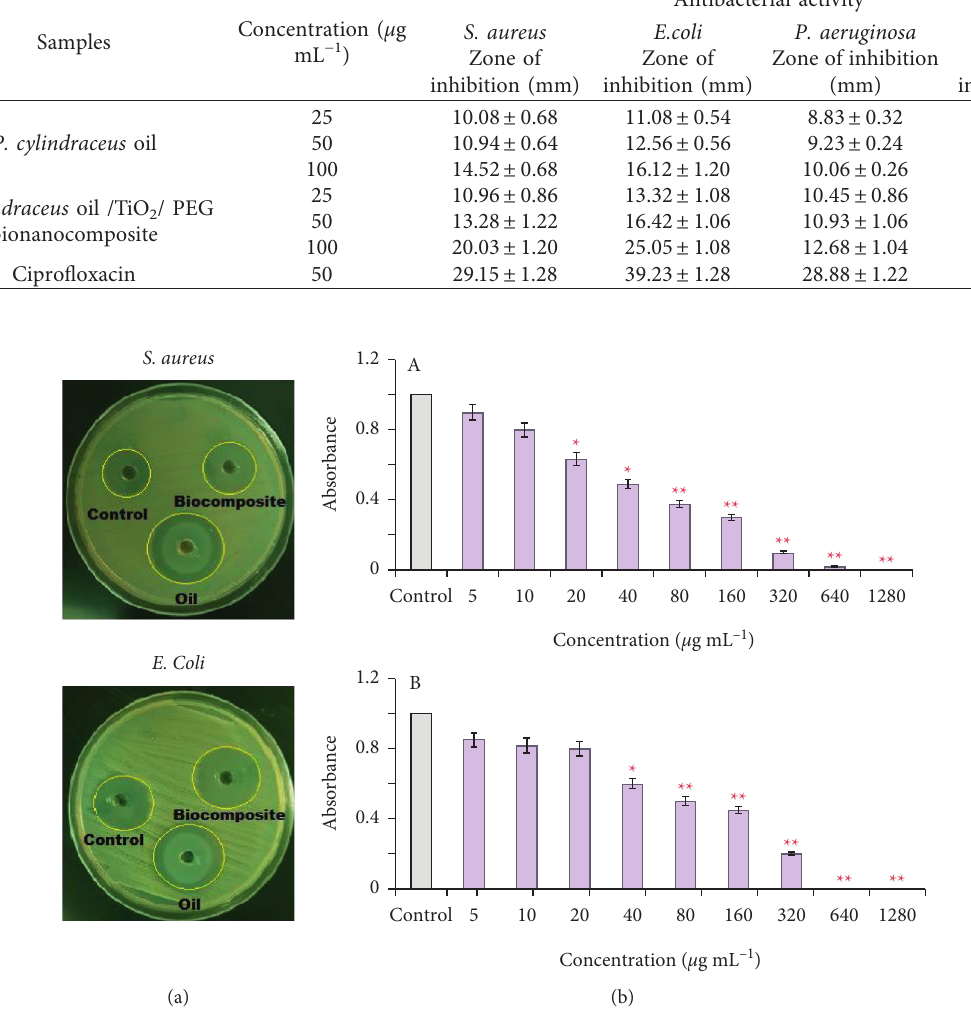
Figure 8: (a) Antibaterial activity of the polymeric P. cylindraceus oil-TiO 2 -PEG bionanocomposite against S. aureus and E. coli and (b) minimum bactericidal concentrations ( μ g/ml) of the polymeric bionanocomposite against (A) S. aureus and (B) E. coli. Results are demonstrated as mean ± SD of triplicate